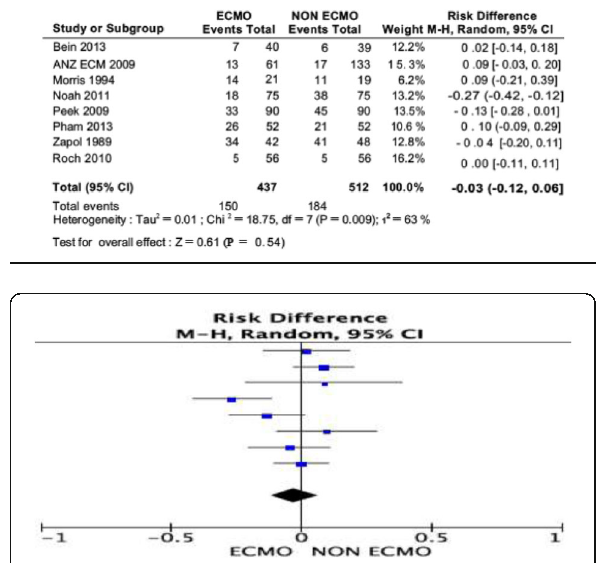
Table 1 (abstract 0029). Mortality between ECMO and NON ECMO patients